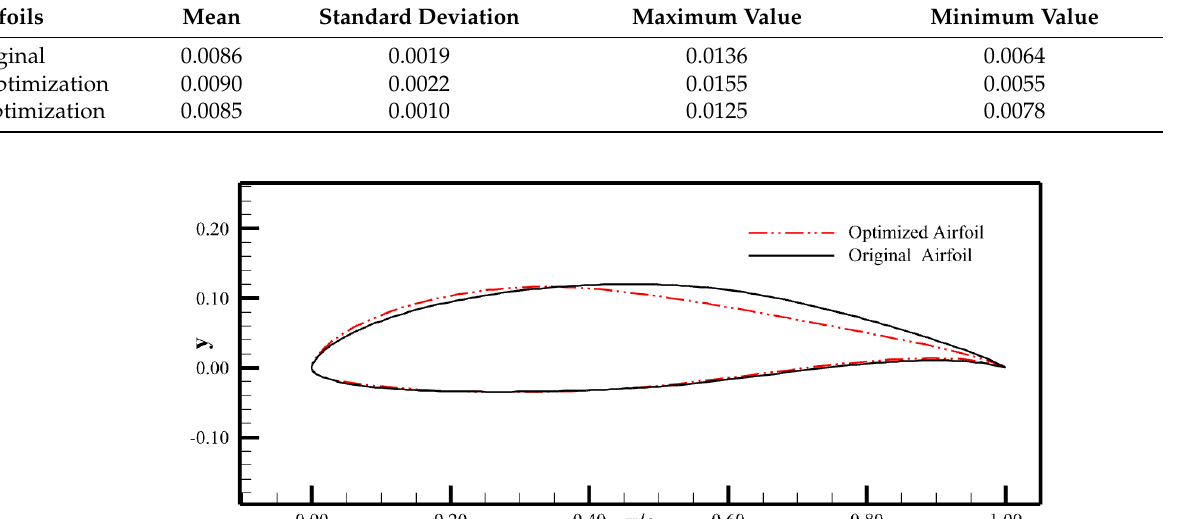
Figure 15. Comparison of airfoils before and after robust optimization based on triangular probability distribution.